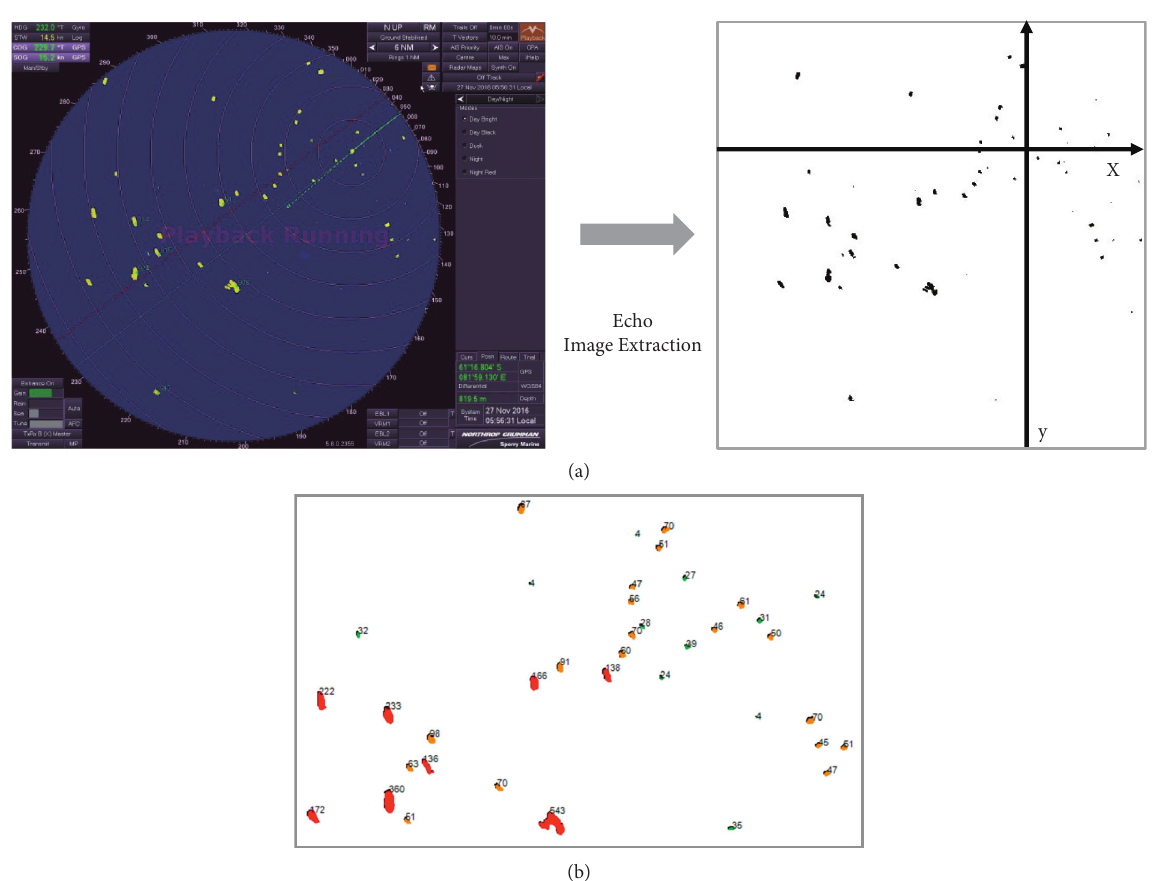
Figure 3: Preprocessing and recognition of ice radar images. (a) Segment the background and targets. (b) Label the